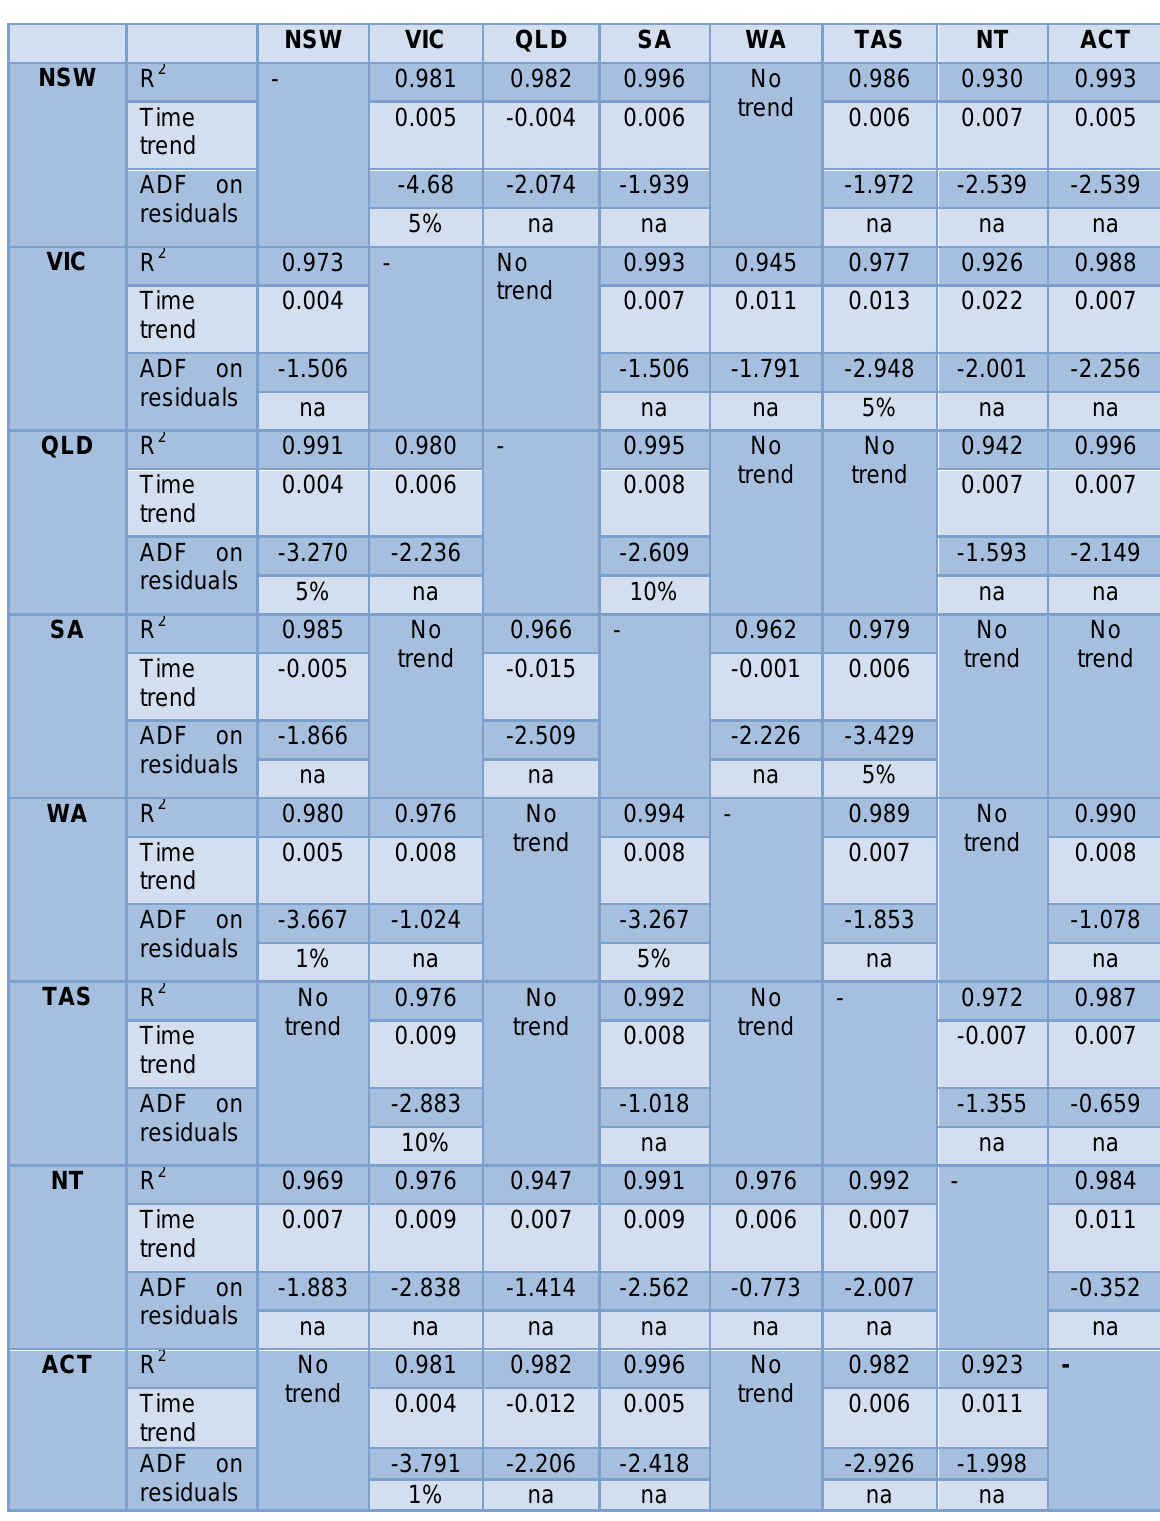
Table 3 Pairwise co-integration test results (with deterministic trend) Note: The percentage number in the ADF on residuals row denotes the significance level when the null hypothesis is rejected